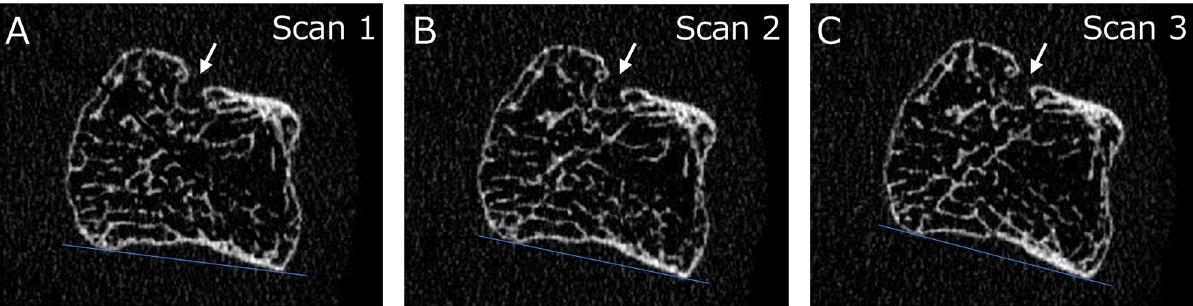
Fig 4. 2D images of a metacarpal head in a healthy woman obtained from three scans with repositioning (white arrows: Erosion). A. 1st scan; B. 2nd scan; C. 3rd scan.